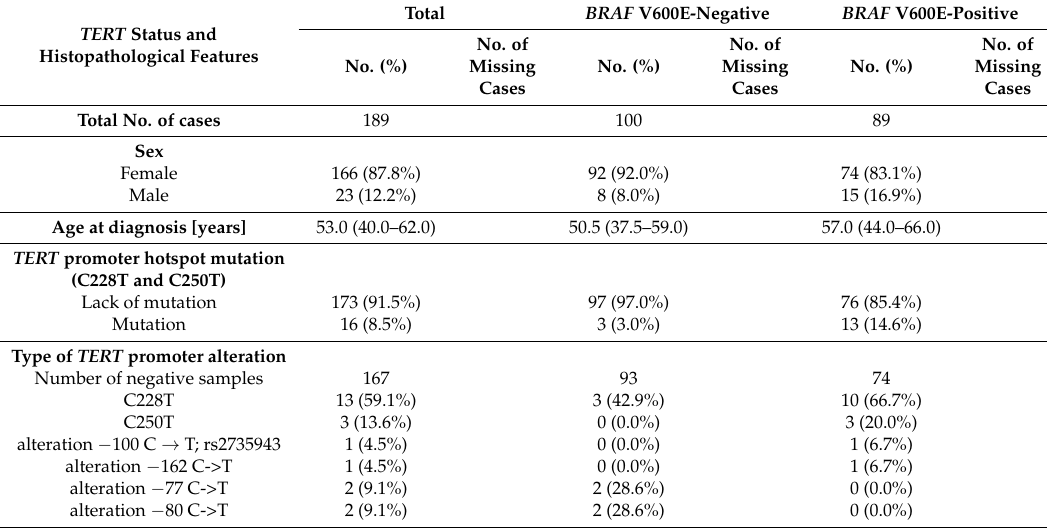
Table 3. Characteristics of the study